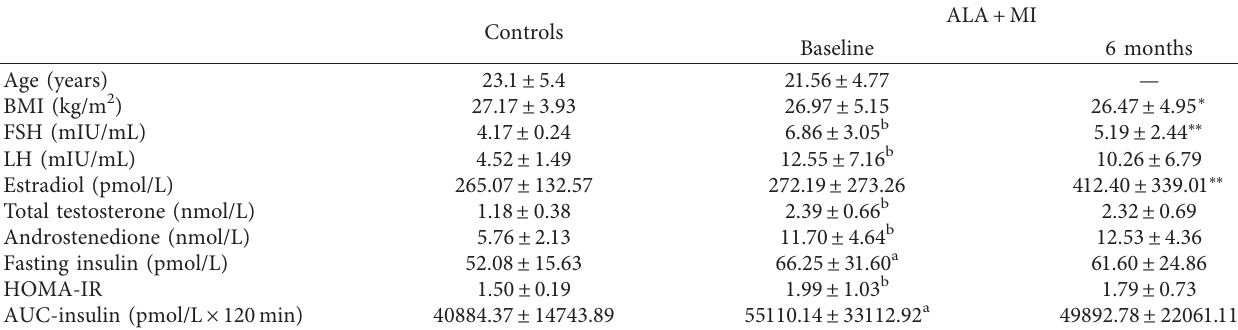
Table 1: Characteristics of the entire group of women at the baseline and after six months of treatment with ALA plus